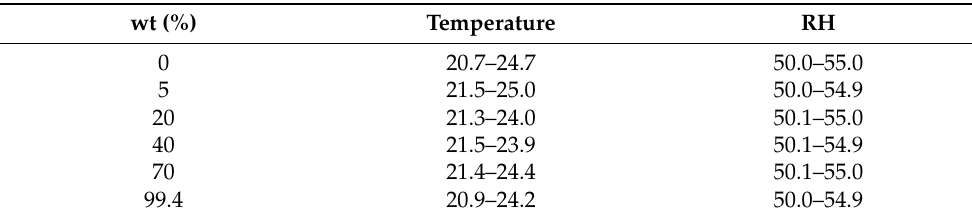
Table 2. Temperature ( ◦ C) and relative humidity (RH) (%) in the present experiment. wt